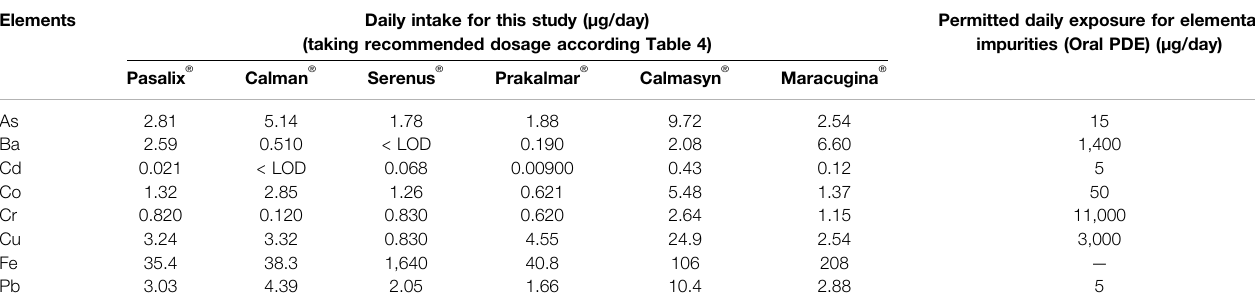
TABLE6| Dailyintakevalue(µg/day)oftheanalyzedherbalmedicinesmeasuredhere(takingrecommendeddosageaccording Table4 )comparedtorecommendedvalues by United States Pharmacopeia (USP).